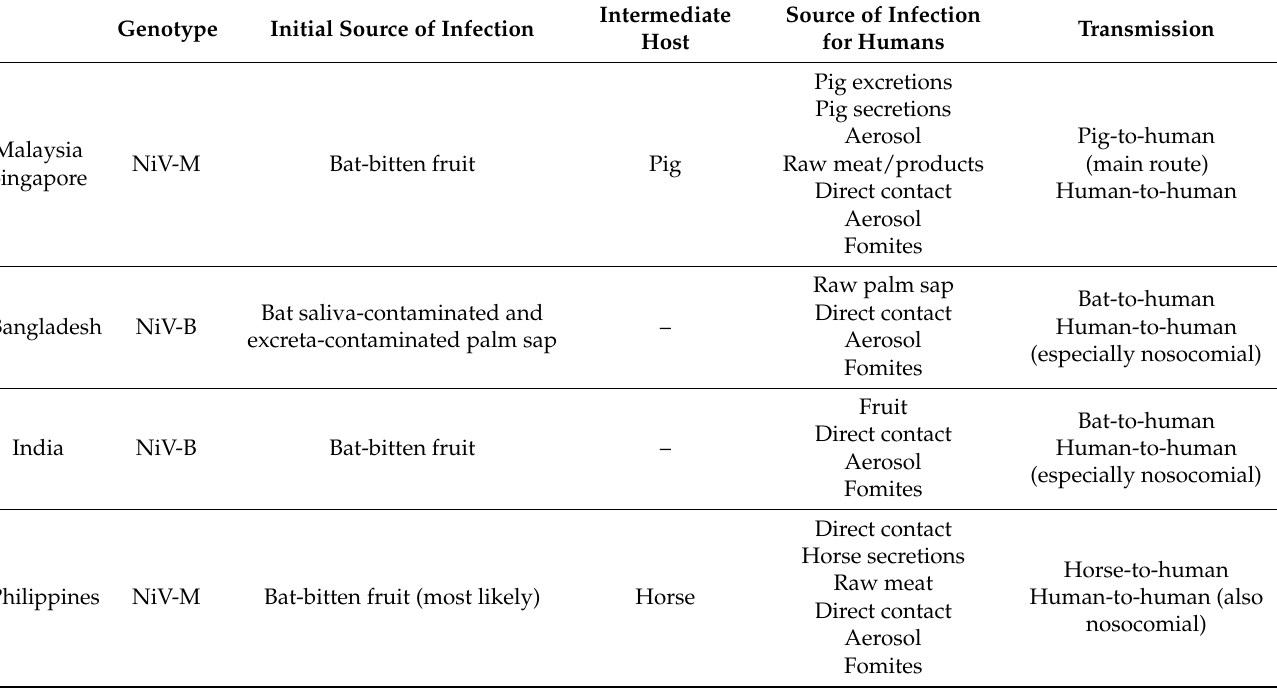
Table 1. NiV genotypes and routes of transmission based on the countries where outbreaks occurred